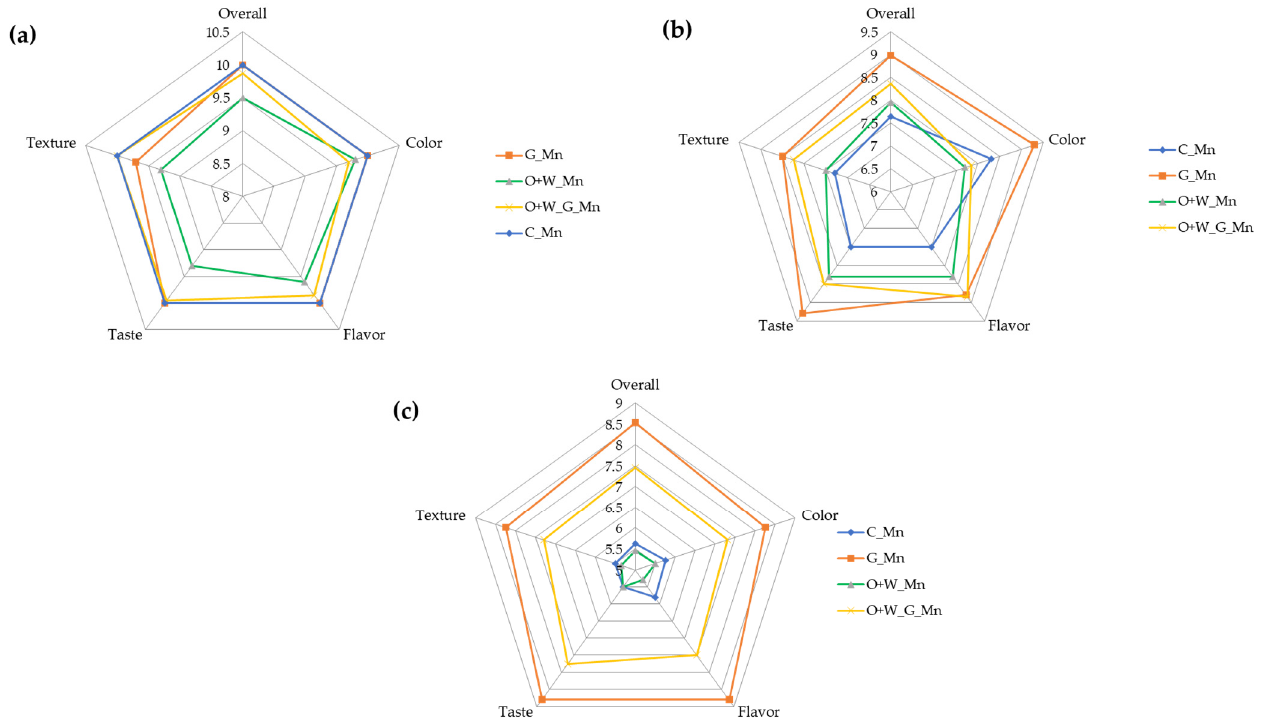
Figure 8. The effects of different treatments on the sensory evaluation of mulberry on T0 ( a ), T5 ( b ) and T8 ( c ) of storage at refrigeration temperature (4 °C).